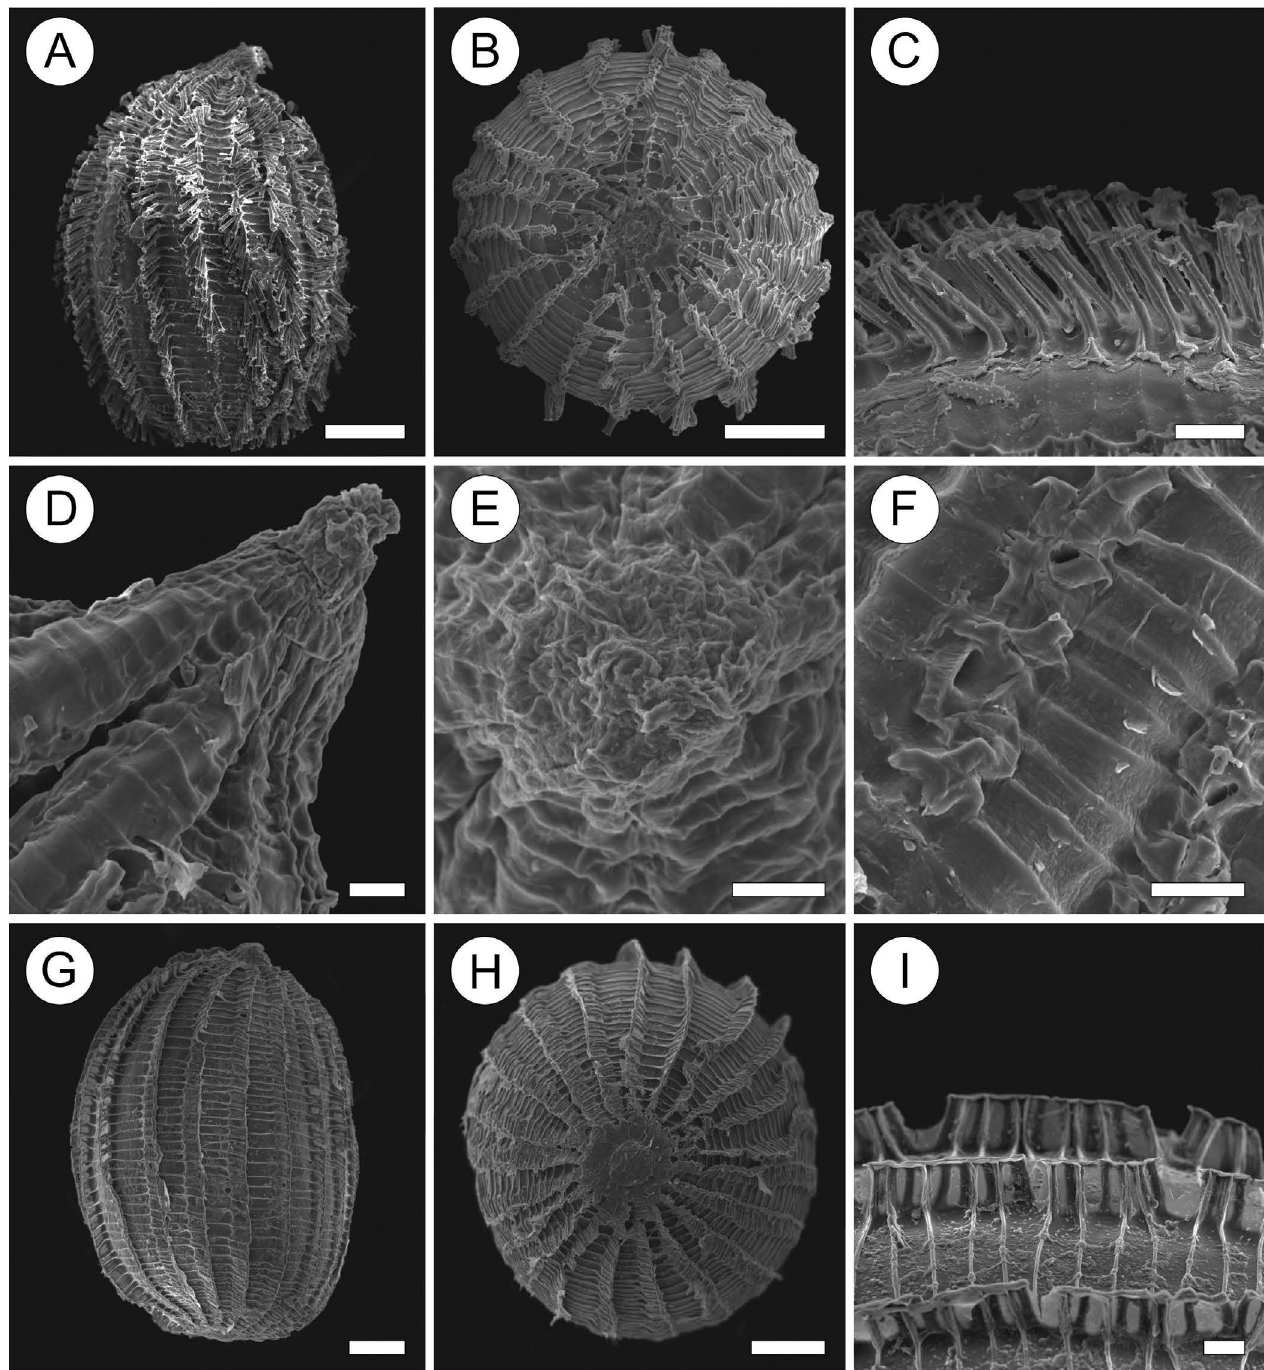
Figure 4 – Scanning electron photomicrographs of seed testa ornamentation of Paepalanthus decumbens and allied species. A–C, P. decumbens (from Picanço et al. 69, R); D–F, P. microphyllus (from Giulietti et al. CFSC7359, SPF); G–I, P. stannardii (from Harley et al. 24476, SPF). A, lateral view of the seed making evident the apex turned to the distal face of the seed; B, base of the seed with the operculum in the middle of a cavity; C, detail of the secondary sculpture of the external tegument; D, seed apex; E, detail of the inconspicuous operculum; F, detail of the primary sculpture of the external tegument; G, lateral view of the seed; H, base of the seed showing an evident operculum bordered by a ring of fused cell walls; I, detail of the secondary sculpture of the external tegument where it is possible to see the anticlinal cell wall projections in the corners of the external cell wall outline. Scale bars: A, B, G & H = 100 µm; C–F & I = 20